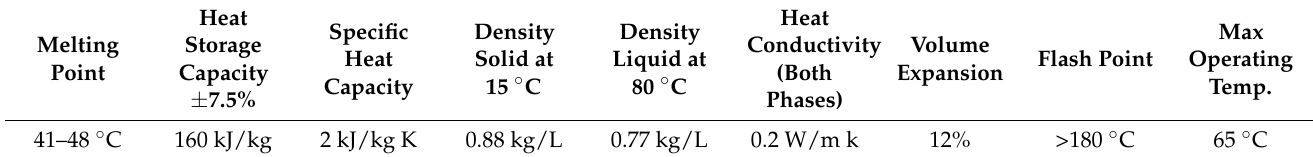
Table 2. The specifications of the RT-47 PCM used in the present work